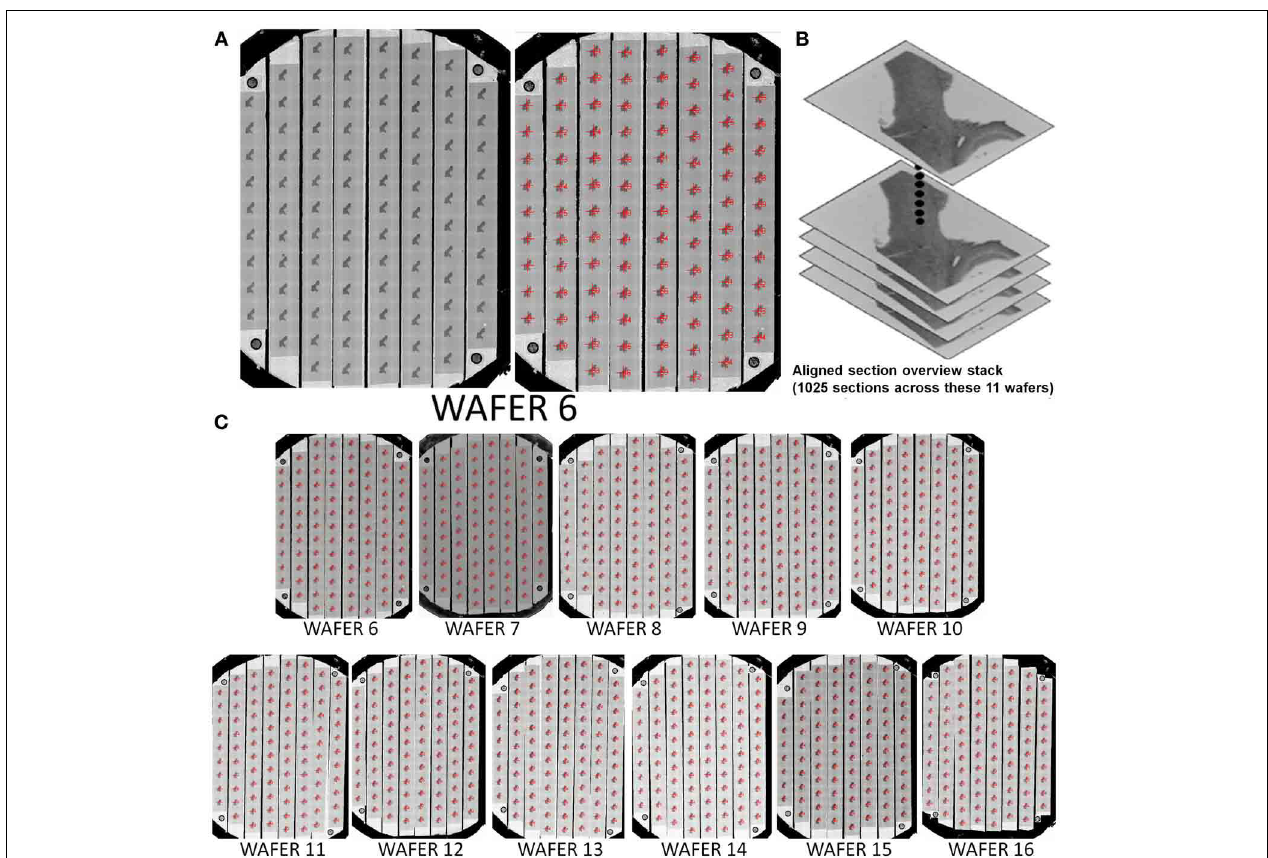
FIGURE 6 | Example of a 1025 section UTSL of mouse cortex tissue spanning 11 wafers. A full wafer SEM montage image of each wafer was taken and used as the basis of automapping all sections. (A) Full wafer SEM montage of wafer 6 (right), same